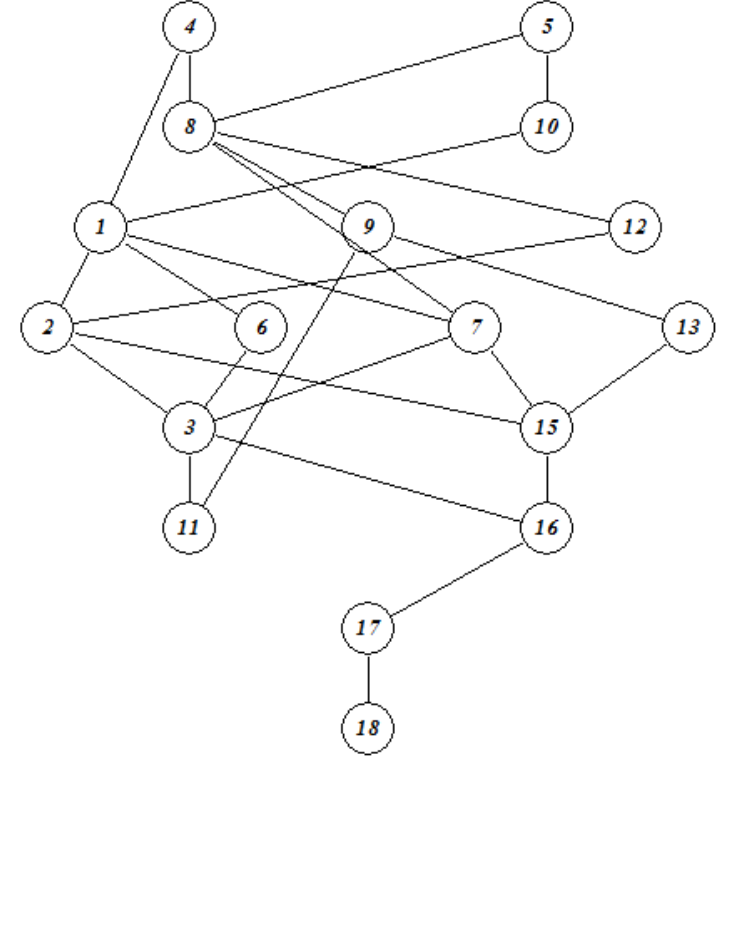
Figure 5 . Hasse diagram constructed based on the meta descriptors originating from the ToxBoxes and the PASS calculations, respectively, cf. Table 7